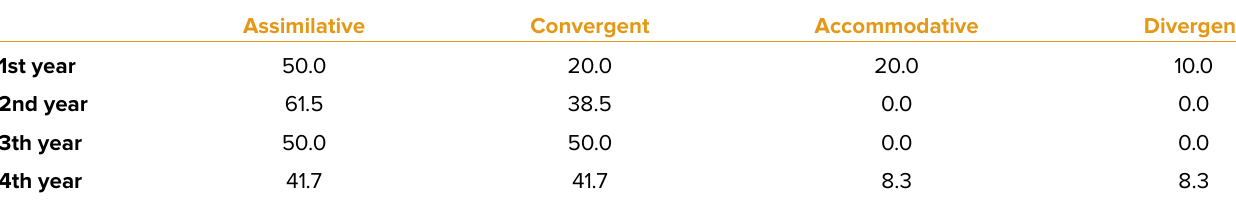
Figure 2. Frequency distribution of Kolb’s learning styles according to gender. Table 1. Distribution of Kolb’s learning styles (in %) according to the year of residency Assimilative